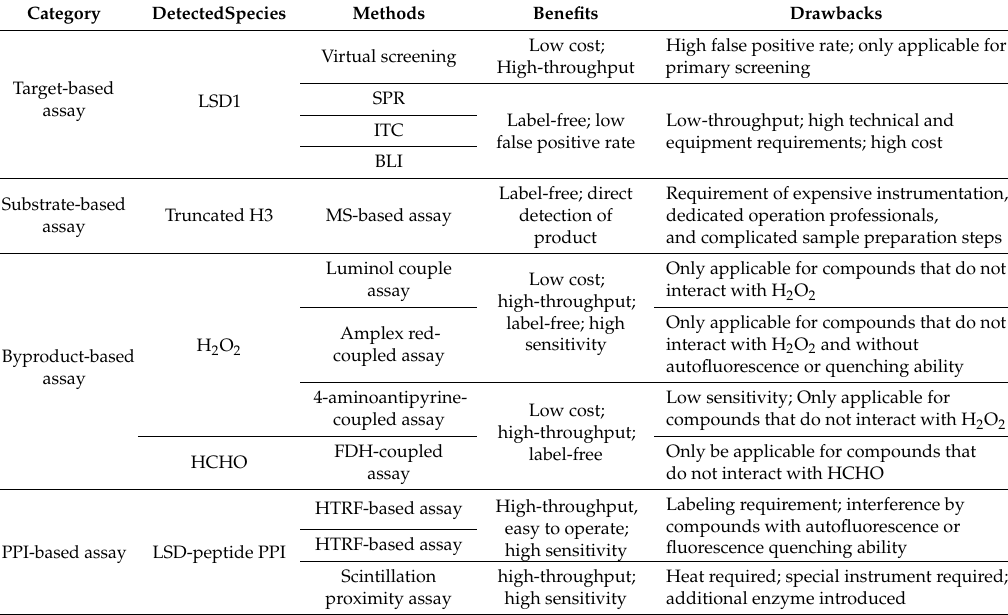
Table 2. Comparison of different screening methods for